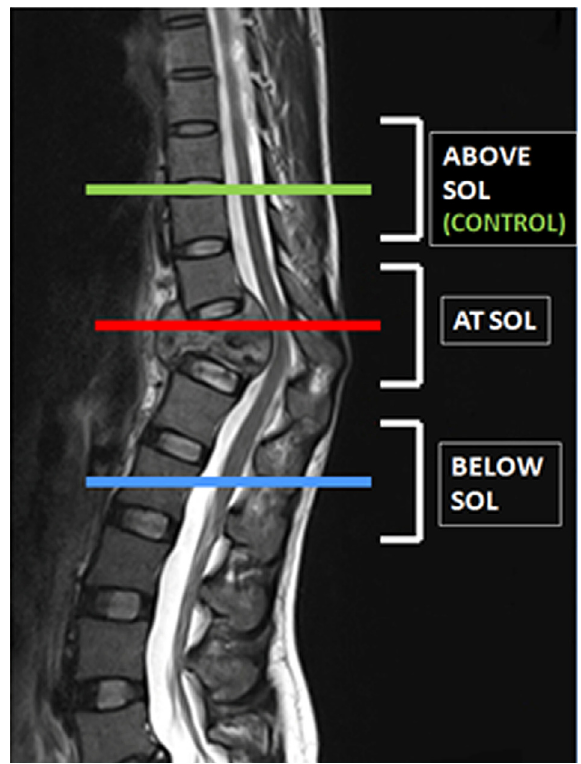
Figure 3. Levels of site of lesions (SOL) as marked on a T2 sagittal MRI image.